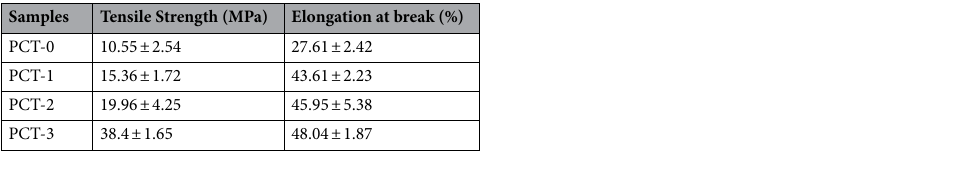
Table 5. Mechanical properties of PVA/CMC/TUR